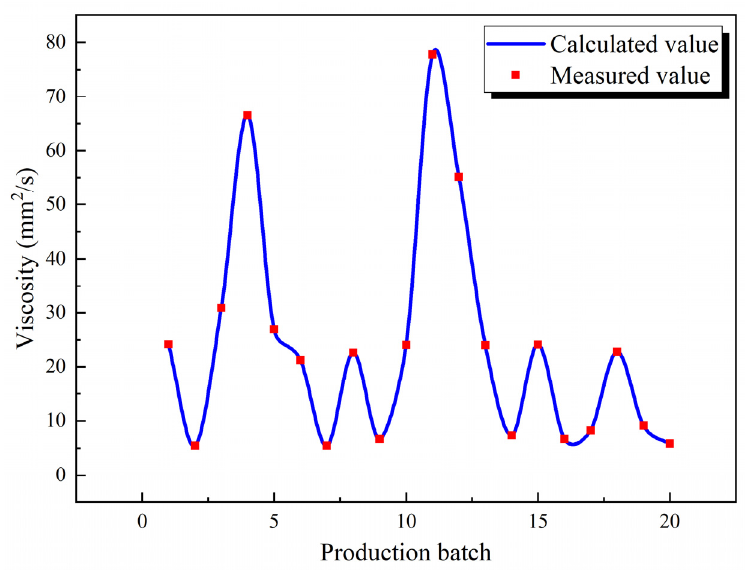
Figure 2. Comparison between the calculated value and measured value of viscosity.